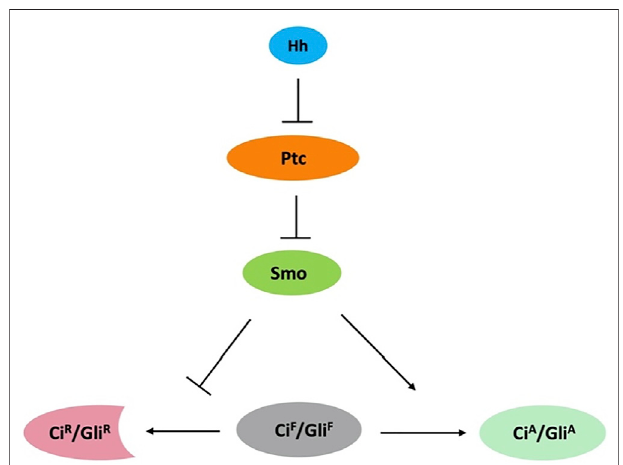
FIGURE 1 | Conserved Hh signaling pathway. Binding of Hh to Ptc releases its inhibition of Smo. Smo inhibits the processing of full-length Ci/Gli (Ci F /Gli F )intoitsrepressorform(Ci R /Gli R )andconvertsCi F /Gli F intoitsactivator form (Ci A /Gli A